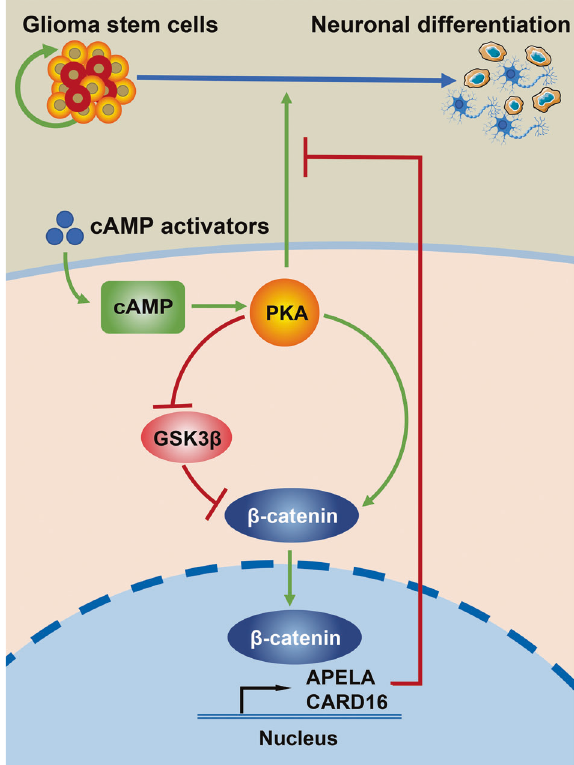
Fig. 7 The schematic diagram shows the proposed mechanism that cAMP activates β -catenin through PKA and GSK3 β , and afterwards promotes transcription of the downstream genes APELA and CARD16, which eventually prevent neuronal differentiation in